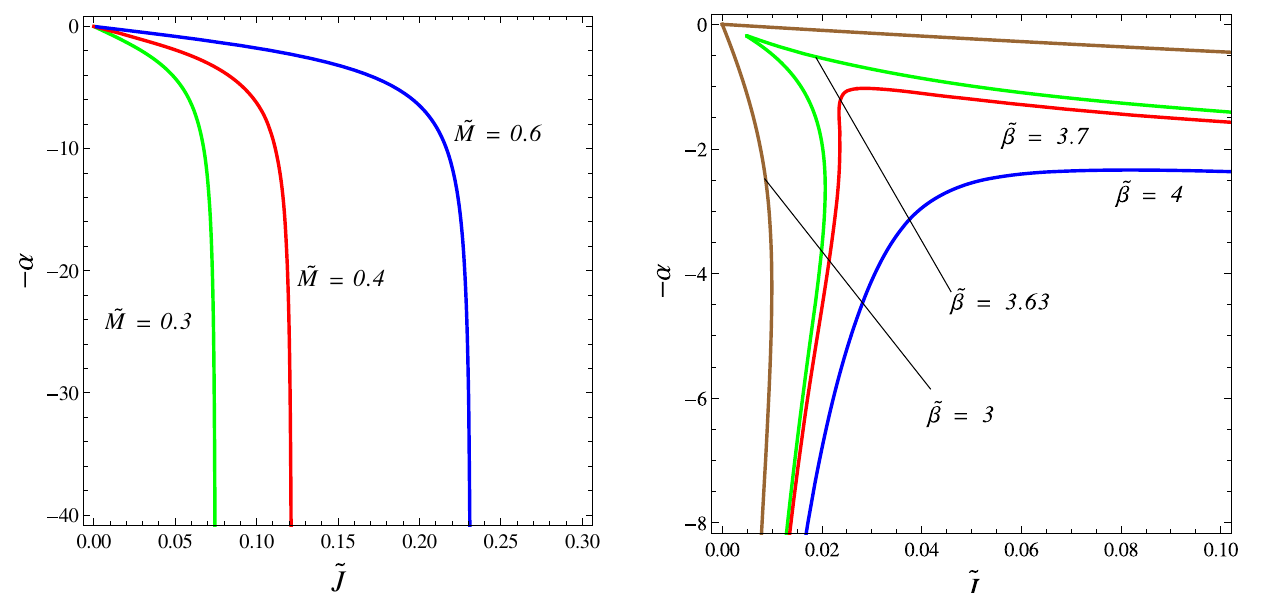
Fig. 19 Curves of the conjugate variable − α( J ) at fixed β for Kerr– AdS black holes in the canonical ensemble. The curves of ˜ β = 3 (brown), ˜ β = 3 . 63 (green), ˜ β = 3 . 7 (red) and ˜ β = 4 (blue) are plotted. The ˜ β = 3 . 63 (green) curve has two turning points, while the ˜ β = 3 (brown) curve has two branches and the lower branch has a turning point